Question: Is the quantity shown trending increasing or decreasing?
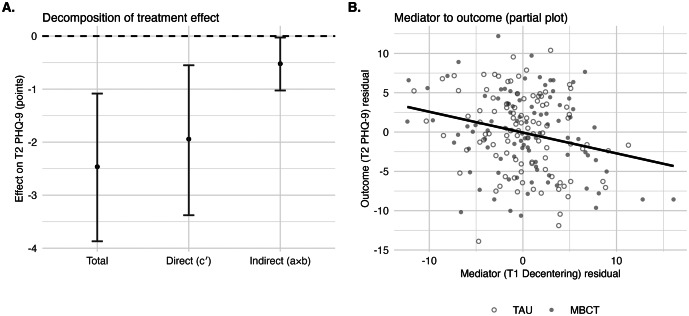
Answer: increasing